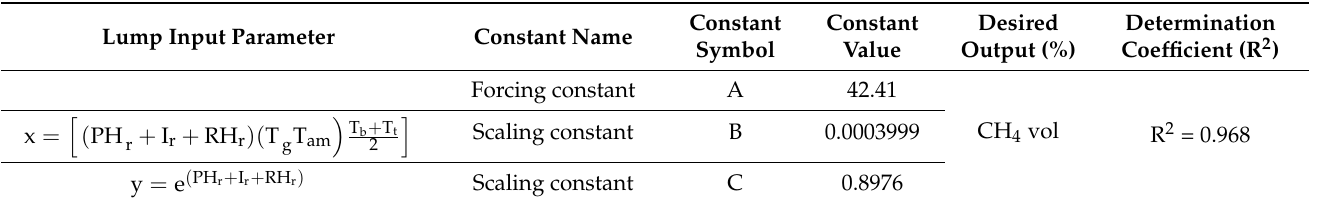
Table 4. Methane model equation constants and determination coefficient for the underground biogas